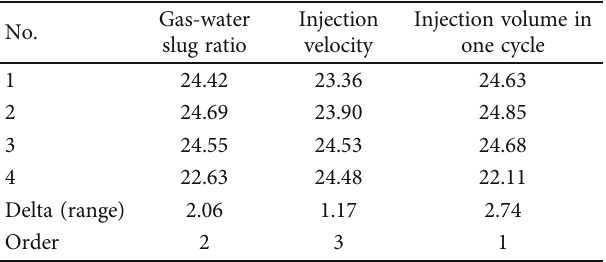
Table 5: Mean response statistics of orthogonal